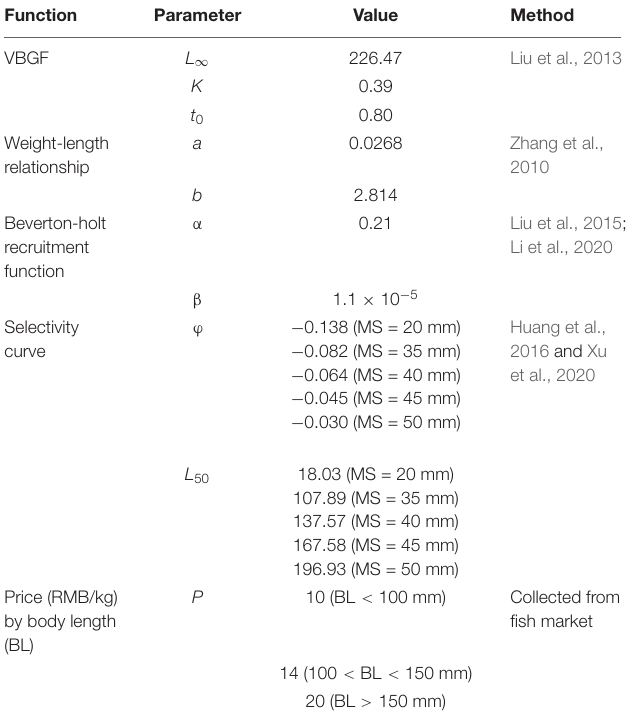
TABLE 1 | Parameters for the small yellow croaker in bio-economic model.